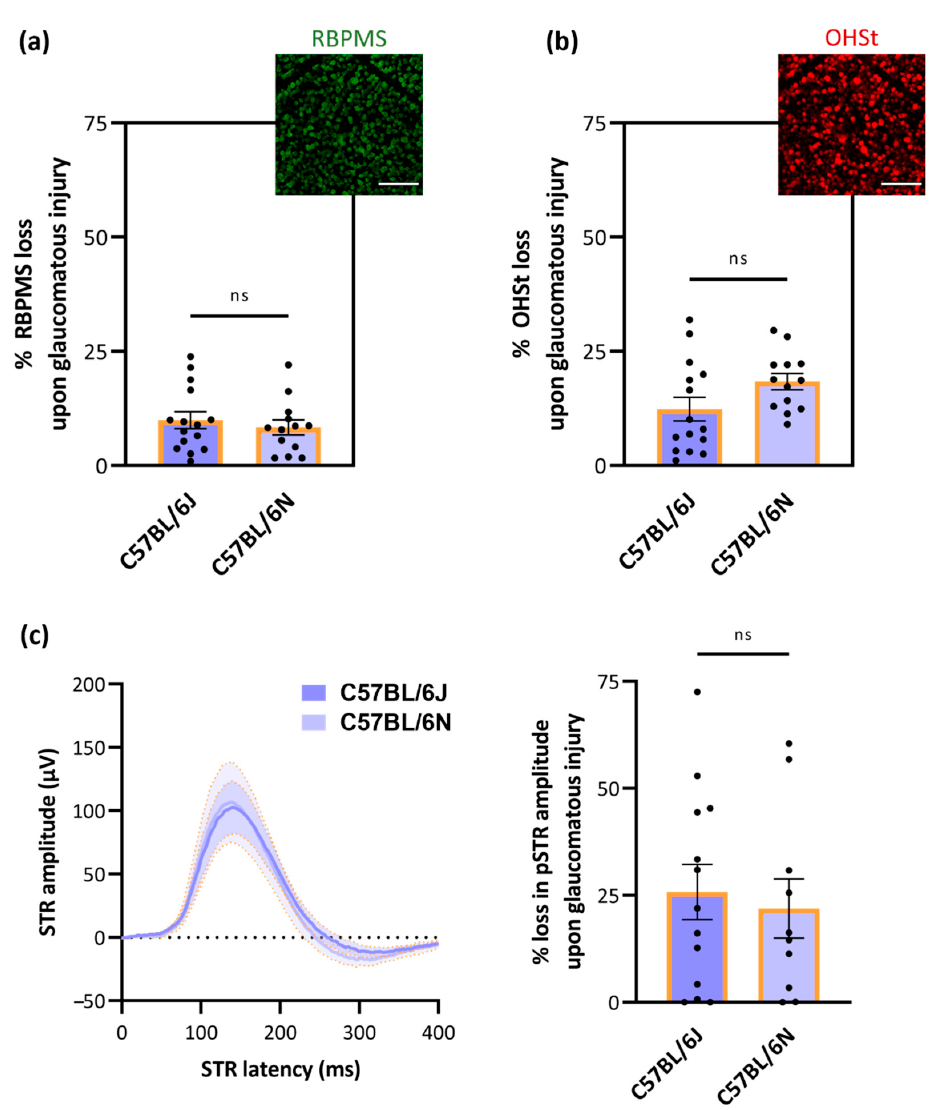
Figure 4. Loss of RBPMS + and OHSt + RGCs versus decline of RGC functionality across (young) C57BL/6J and -N mice with glaucomatous, microbead-occluded eyes. At five weeks post-microbead injection, no difference in RGC susceptibility was observed: the loss of RBPMS + RGCs ( a ) and OHSt + RGCs ( b )—both quantified via the automatic counting tool RGCode—was identical in each substrain ( n = 15 for C57BL/6J mice and 13 for C57BL/6N mice). Similarly, no difference in the decline of pSTR amplitude ( c ) upon glaucomatous injury was observed between C57BL/6J- and N mice ( n = 13 for C57BL/6J mice and 10 for C57BL/6N mice). RBPMS, OHSt and pSTR amplitude loss is expressed relative (%) to the values of the contralateral uninjured eyes. Scale bar = 100 µm. Unpaired, two-tailed t -test (% RBPMS and OHSt loss) or one-ANOVA with Tukey’s post hoc test (loss in pSTR amplitude); ns =